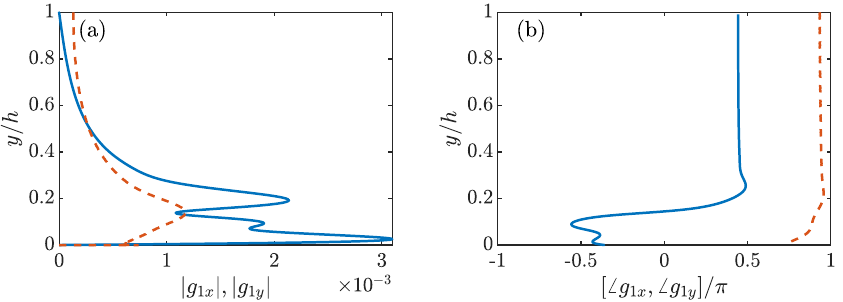
Figure 12. The ( a ) amplitude and ( b ) phase of the g 1 component of the boundary induced forcing. Blue solid line is the streamwise direction forcing g 1 x and red dash line is the wall-normal direction forcing g 1 y . The parameters are Re τ = 410, and ( k x , k z , c + ) = ( 2.78,0,14.08 ) for the compliant wall with Y = 0.003 i